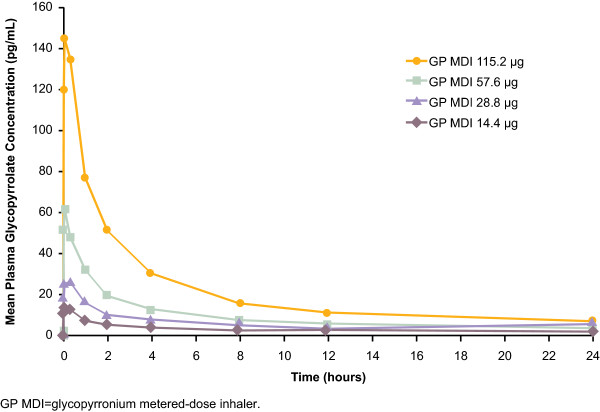
Mean plasma glycopyrronium concentrations over time.